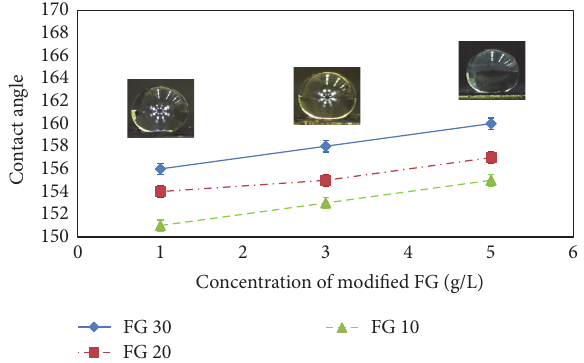
Figure 4: The relationship between the contact angle of the modified FG substrates and the different concentration of modified FGsuspensionfor1,3,and5 g/latdifferentfluorinationdegreesVFG 10, VFG 20, and VFG